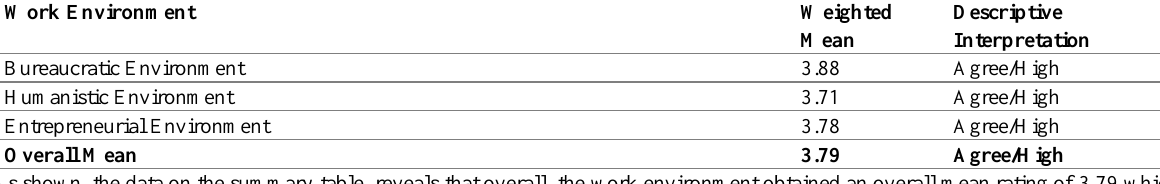
Table 7: Summary Table: Work Environment